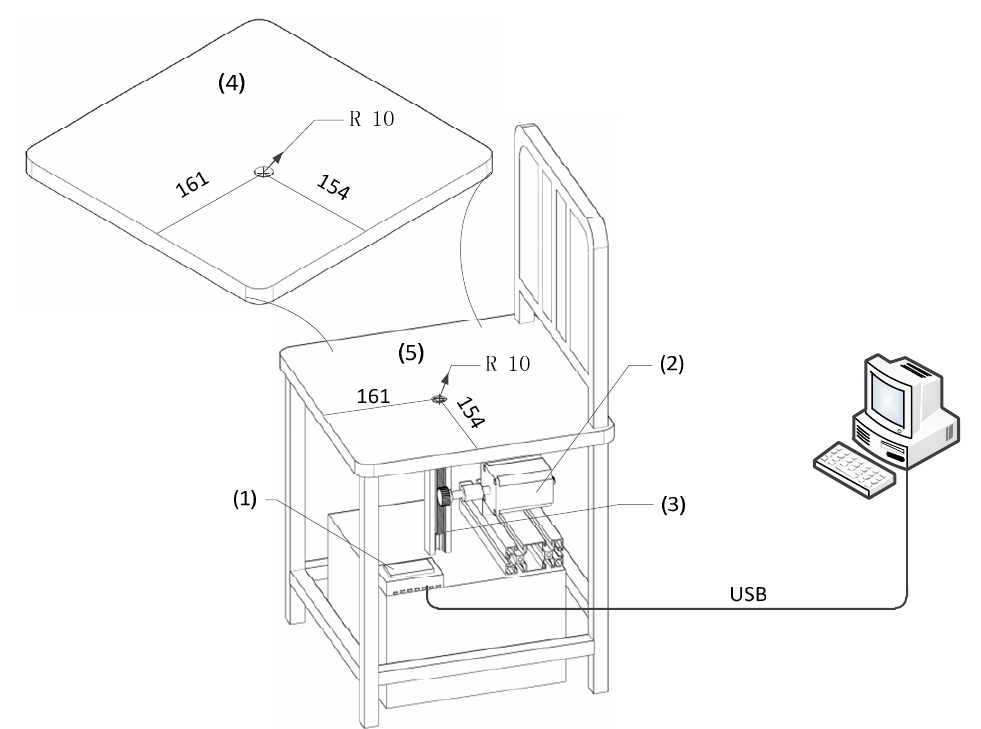
Figure 1. Configuration of the sensor movement system. Major components included: (1) data acquisition unit, (2) stepping motor, (3) transportation mechanism, (4) custom-made foam cushion with a drilled hole and (5) the wooden chair surface configured with the same hole. Both the customised cushion and the chair had equal dimensions (399 × 378 mm, length and width,